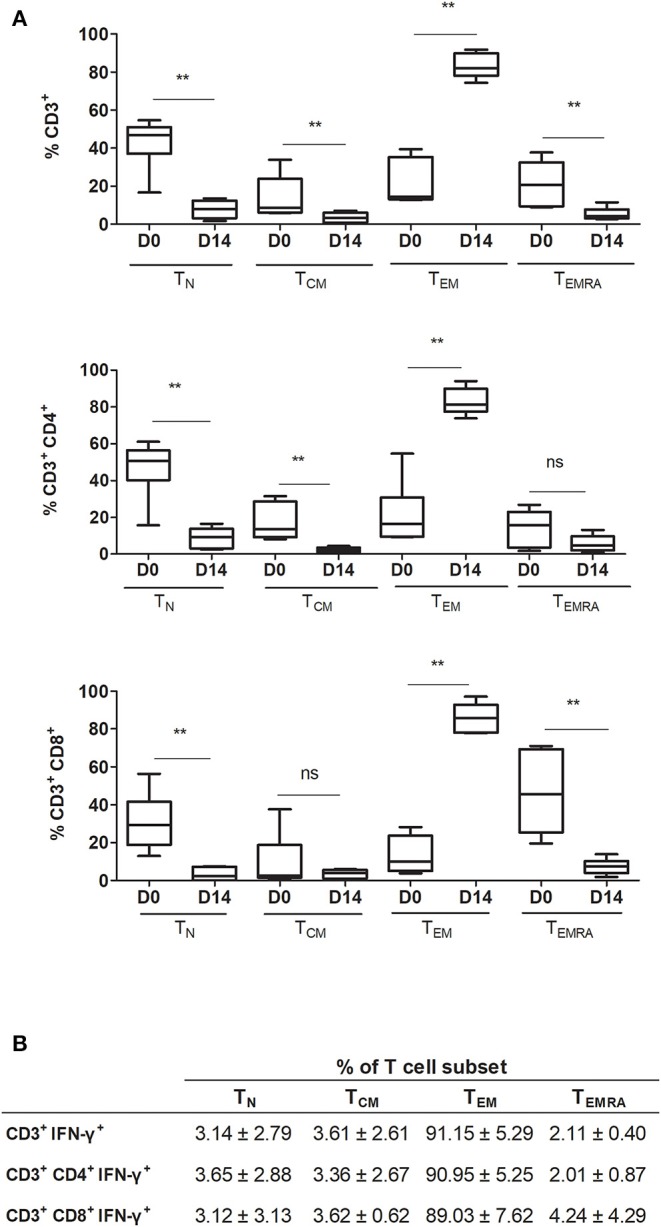
Frequency of different T cell differentiation subset phenotypes in the final product. (A) Comparison between pre-expansion and post-expansion for CD3+, CD3+CD4+, and CD3+CD8+ subpopulations (n = 6). (B) T cell differentiation phenotypes in post-expansion IFN-γ+ T cells (n = 4). TN indicates naïve T cell (CCR7+CD45RA+); TCM, central memory T cell (CCR7+CD45RA−); TEM, effector memory T cell (CCR7−CD45RA−); and TEMRA, terminally differentiated effector memory T cell (CCR7−CD45RA+). **p < 0.01 (Mann-Whitney test).